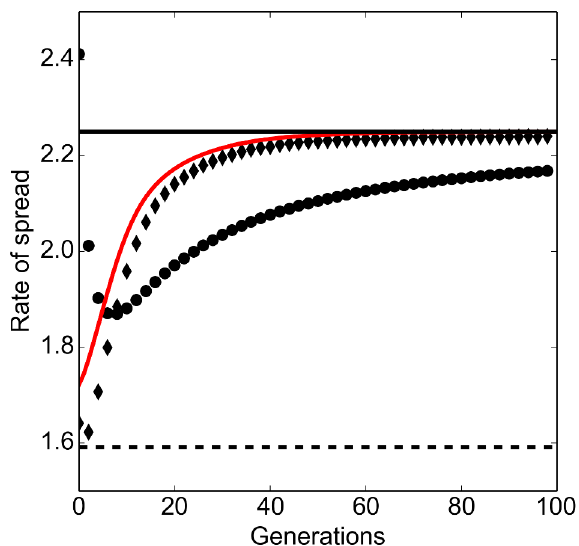
Figure 5. Rate of spread of a mixed population. Parameter values are U 0 ~ 100, K ~ 500, m ~ 0 : 5, s ~ 0 : 25, r ~ 0 : 75 . Diamonds: Instantaneous rate of spread. Circles: Average rate of spread. Solid black line: Predicted asymptotic rate of spread. Solid red line: predicted instantaneous rate of spread (Eq (10)). The rate of spread predicted by a single population model is shown by the dashed line.